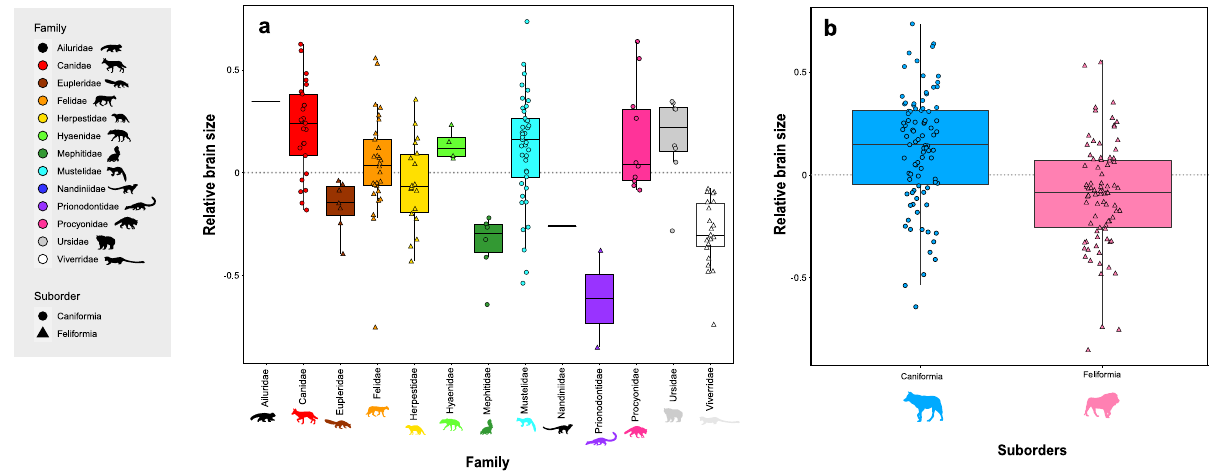
Fig. 3 Patterns of encephalization among carnivoran taxonomic groups. Calculated Phylogenetic relative brain size estimated for a families and b the two suborders. Grey dotted lines indicate the expected relative brain size under an allometric model (i.e., brain size is entirely explained by body mass and explained the entire variation observed for the dependent variable). Boxes represent the third and fi rst quartiles and bold line represents